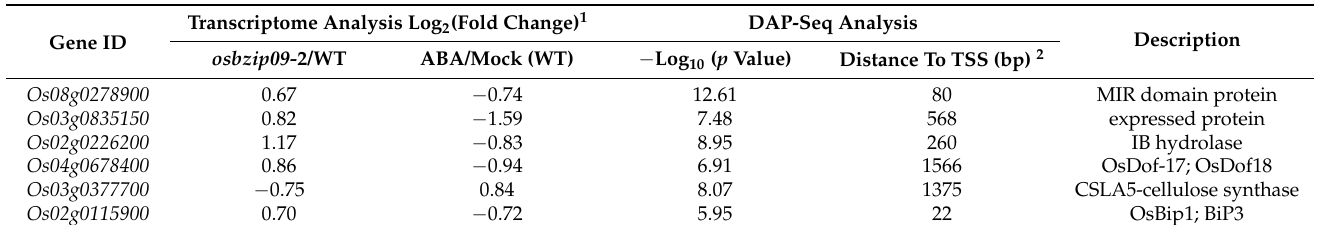
Table 3. List of OsbZIP09 target genes inconsistently regulated by ABA and in osbzip09- 2. Transcriptome Analysis Log 2 (Fold Change) 1 Gene ID